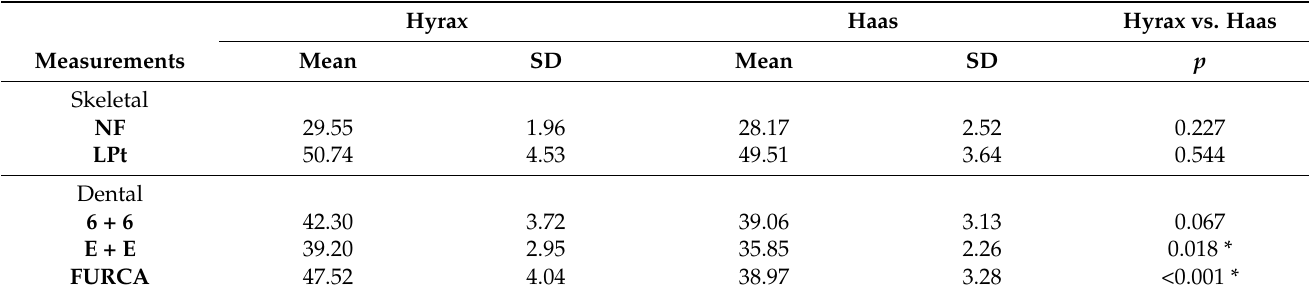
Table 5. Starting forms intergroup comparison at T0 (* p < 0.05).